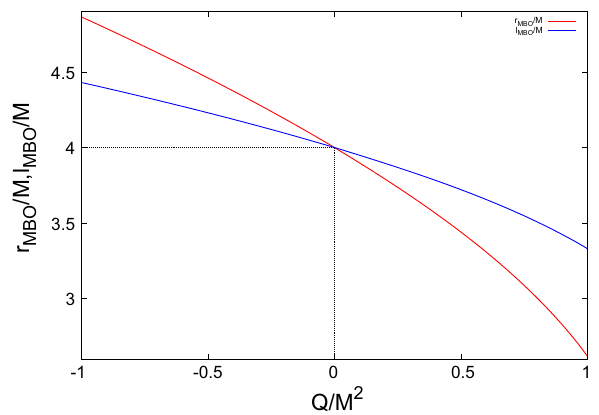
Fig. 2 r MBO (red line) and l MBO (blue line) of the timelike particle around the DMPR brane-world black holes with respect to Q for MBO